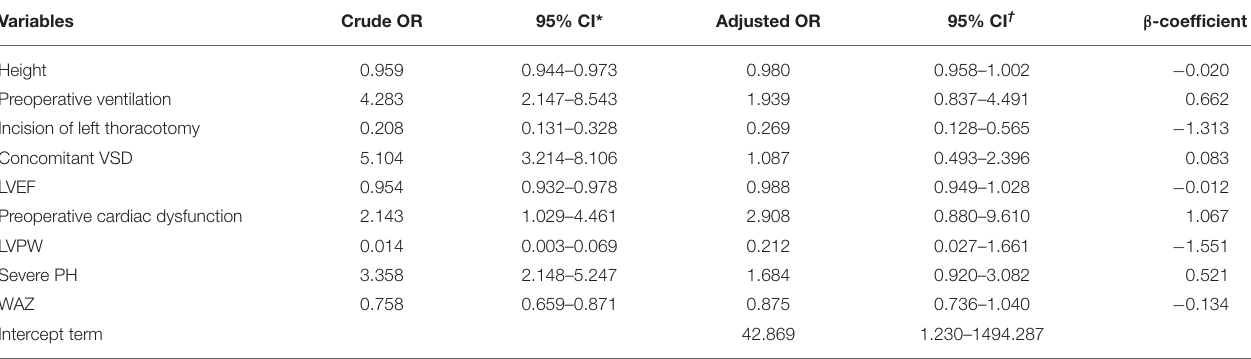
TABLE 2 | Beta coefficients and odds ratios of the newly developed Lasso model. Variables